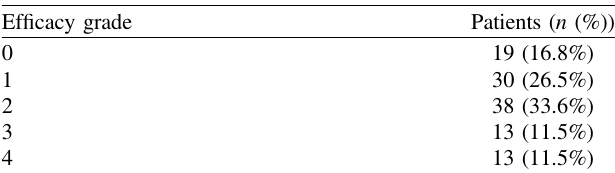
Table 3. The number of patients according to the ef fi cacy